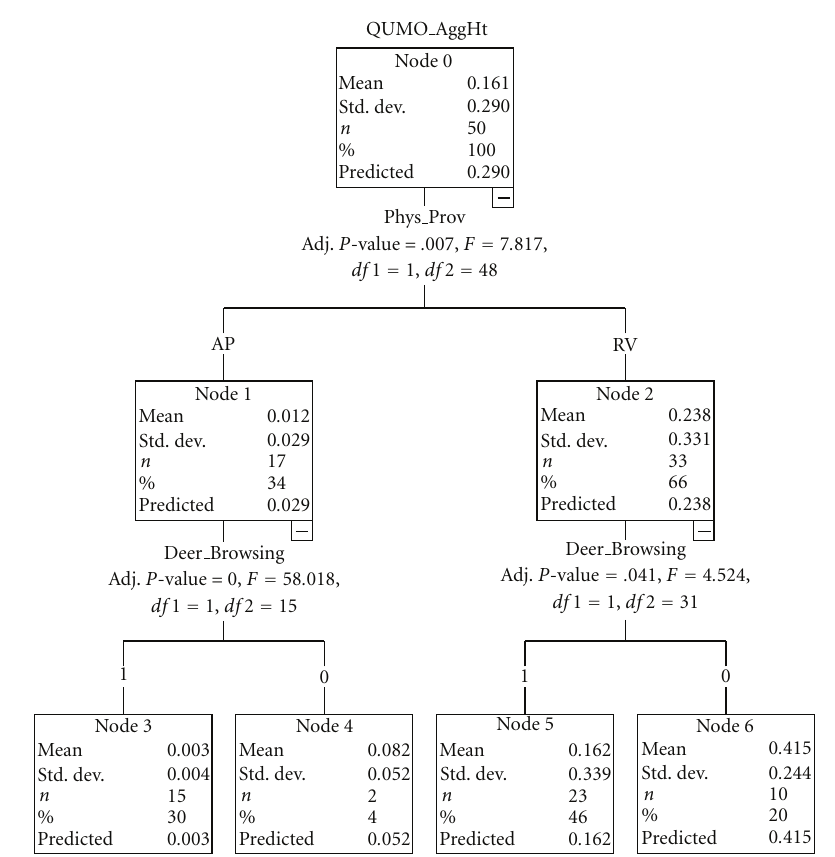
Figure 2: Classification tree for chestnut oak regeneration across the study